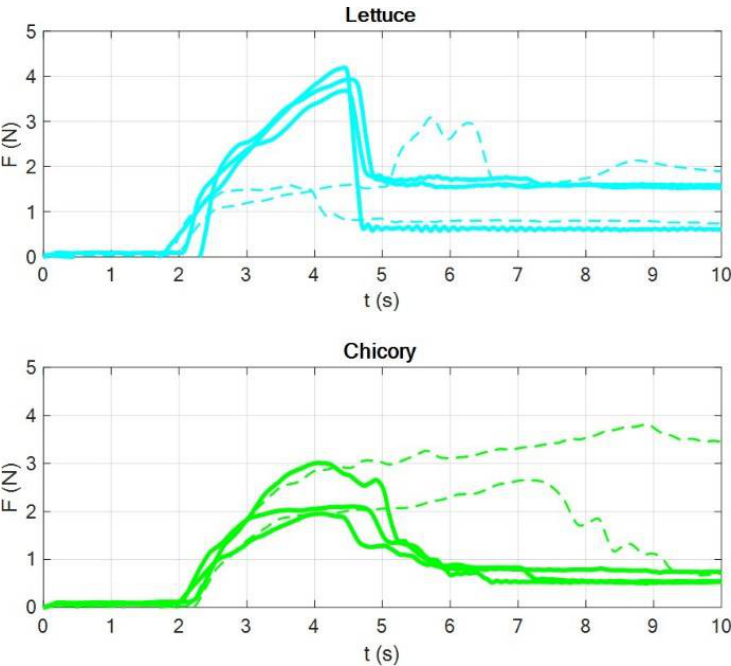
Figure 6. Results of lifting experiment: lettuce ( above ) and chicory ( below ). While lifting lettuce seedlings, the force increased until about 4 N at 4.5 sec and then dropped steeply. A sudden detachment of the plugs from the tray was characteristic for the lettuce seedlings. Two outliers to this behaviour could be observed: in one case, the plug got detached at less than 2 N (Figure 6, above, dashed lines). In the other case, a sliding phase between the fingertips and the leaves was observed until the force increased again and the plug eventually got detached. The detaching of chicory seedlings started at maximum values between 2 and 3 N. The observed detachment of the plugs from the tray was more gradual than with lettuce. This is reflected in the force progressions via a smaller inclination of the decrease after the maximum. Two outliers could also be observed (Figure 6, below, dashed lines). A sliding took place with one seedling, which finally got detached at 7 s. Another seedling could not be lifted at all, and the force increased to 3.8 N at the end of the linear motion when the seedling was still attached to the